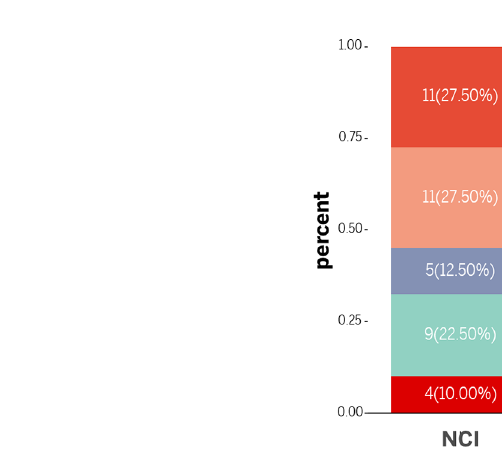
pleural effusion than the NCI group. Figure 4 presented the percentage of different CD>2 postoperative complications.